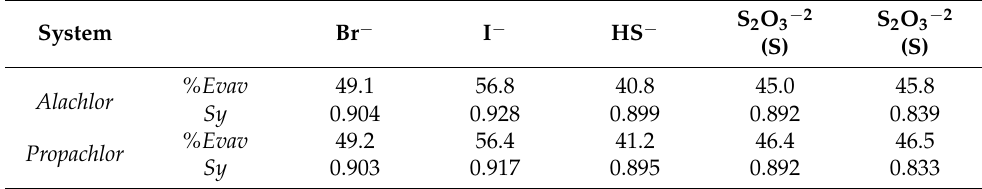
Figure 7. Charge change from reagent to the transition state (R-TS), and from the reagent to the product (R-P) for the nucleophilic attack of alachlor ( a ) and propachlor ( b ). Finally, Wiberg bond indexes (Table S10–S13) were estimated to obtain synchronicity and evolution percentage values. From the results, the C-Cl bond dissociation was found to be the most important event to reach the TS with higher evolution than the C-NU bond in all studied models. The synchronicity and average evolution percentage values for alachlor and propachlor are shown in Table 2. The highest evolution for the C-Cl bond was found for the iodide models which can be reflected in its synchronicity value (~0.92) and the %Evav (~56.5%), which are the highest too. The evolution percentage for the C-Cl compared to C-Nu bond shows a difference between 8% and 10% for all models except S 2 O 3 -2 (O) which presents a 15% difference. For the studied models, only iodide presents a late transition state (%Evav < 50%) while the others present an early TS , with HS - being the earliest (41.8%). All models are shown to be slightly asynchronous, with values be- tween 0.839 and 0.928. Table 2. Average evolution percentage (%Evav) and synchronicity (Sy) for the nucleophilic substitu- tion of alachlor and